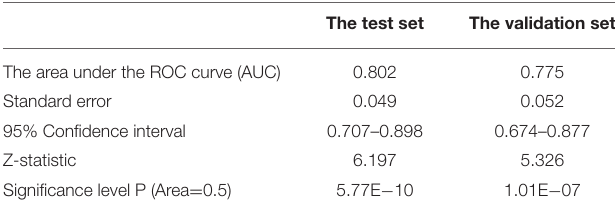
TABLE 3 | ROC curve for the test set and the validation set.